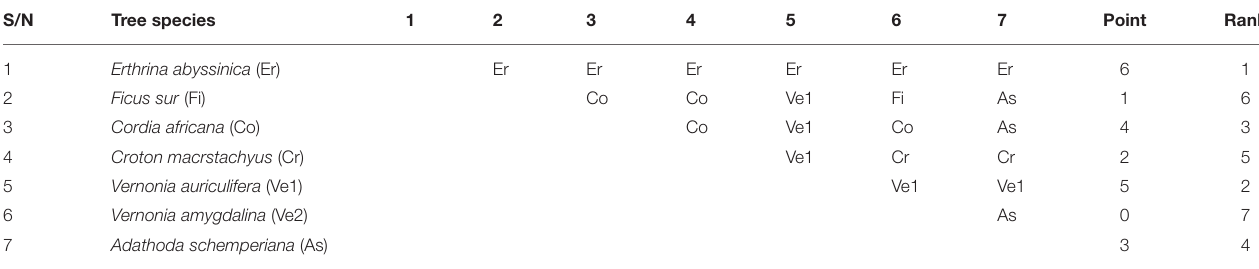
TABLE 3 | Tree species for soil fertility.